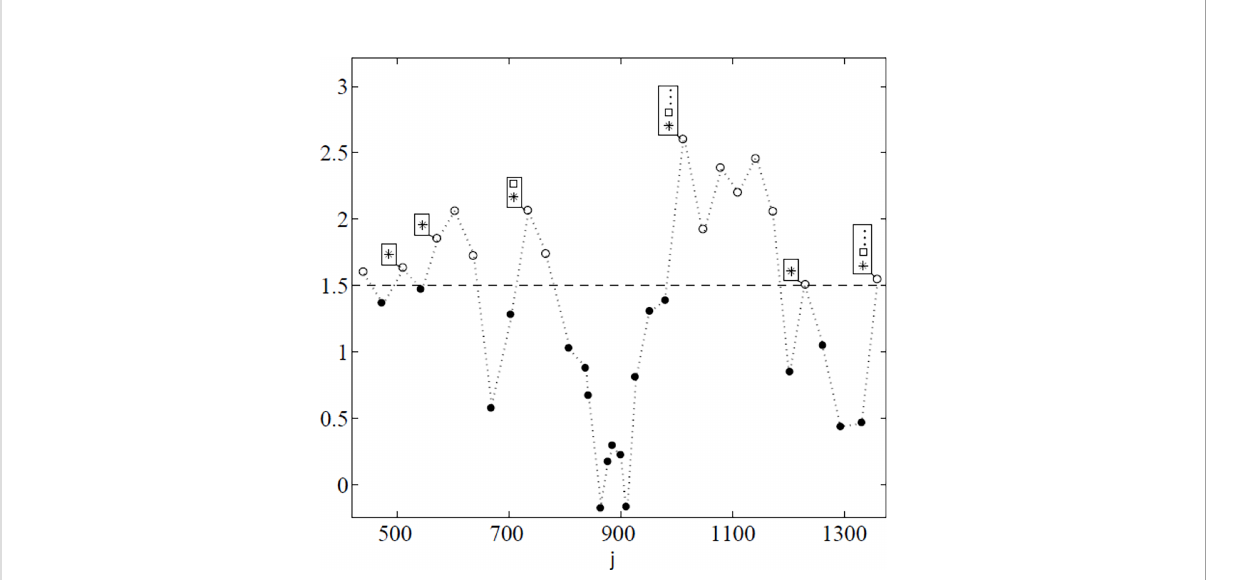
FIGURE 8 Counting of the exceedance for sampled time series with conditioning levels k = 1, … ,3: ● -non-exceedances; ⁰ unconditional exceedances k = 1; * -conditional exceedances with k = 2; □ - with k = 3. Exceedances considered for k > 3 are indicated by three dots ( … ) within rectangles. l = 1.5 was arbitrarily picked as the threshold